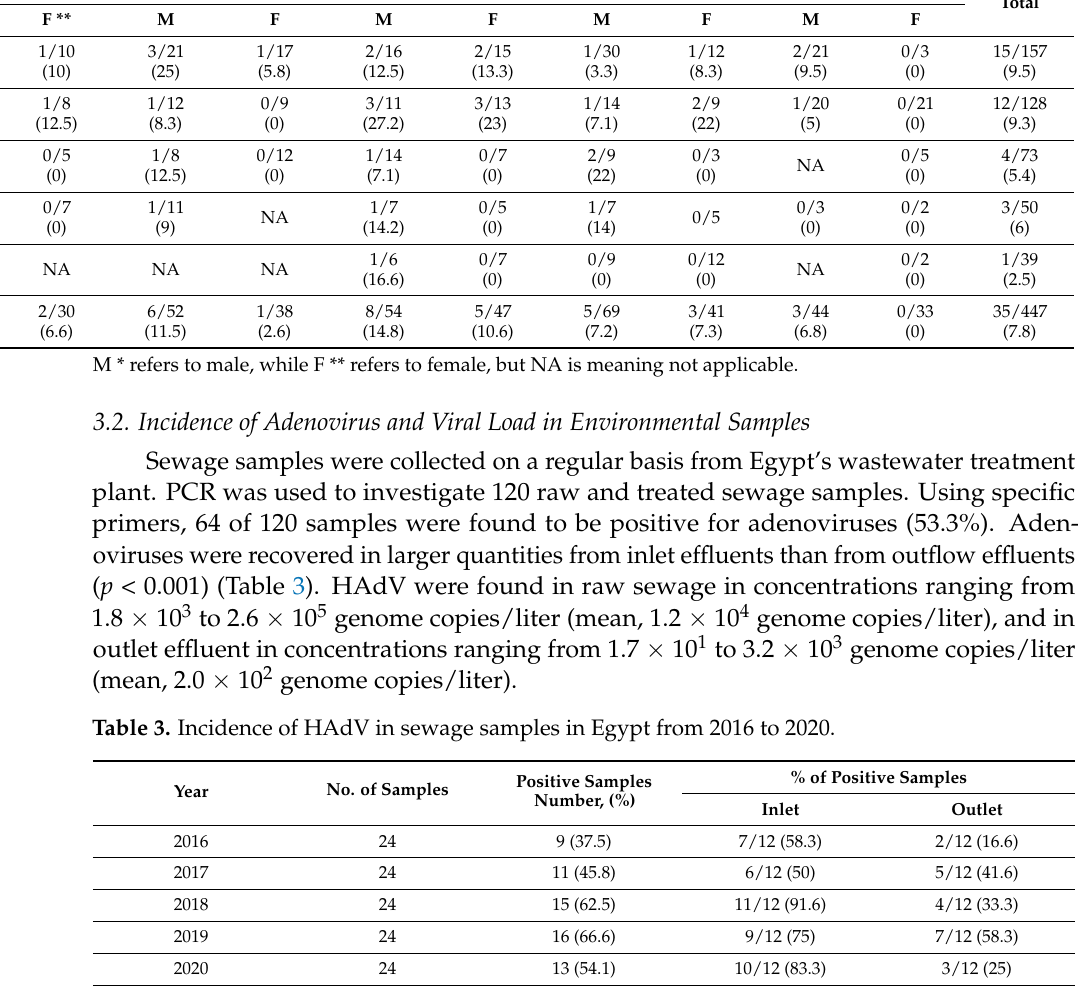
Table 2. Distribution of the adenovirus’ positivity in children according to age groups.